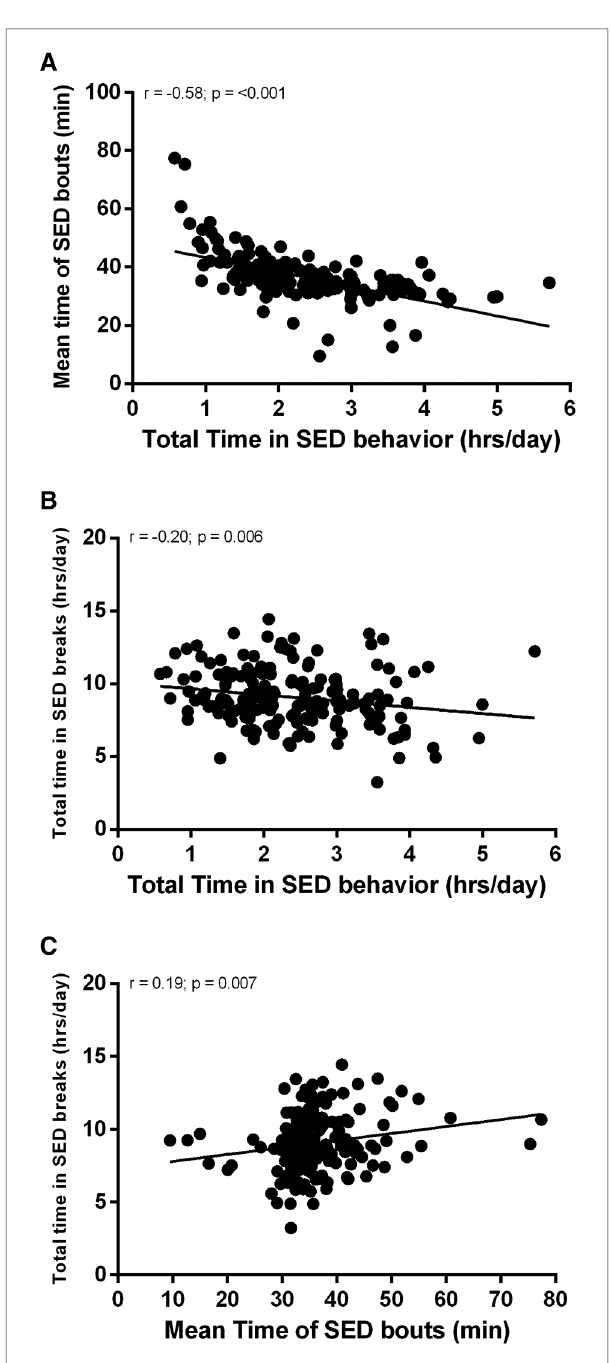
FIGURE 2 Correlation between different parameters of sedentary